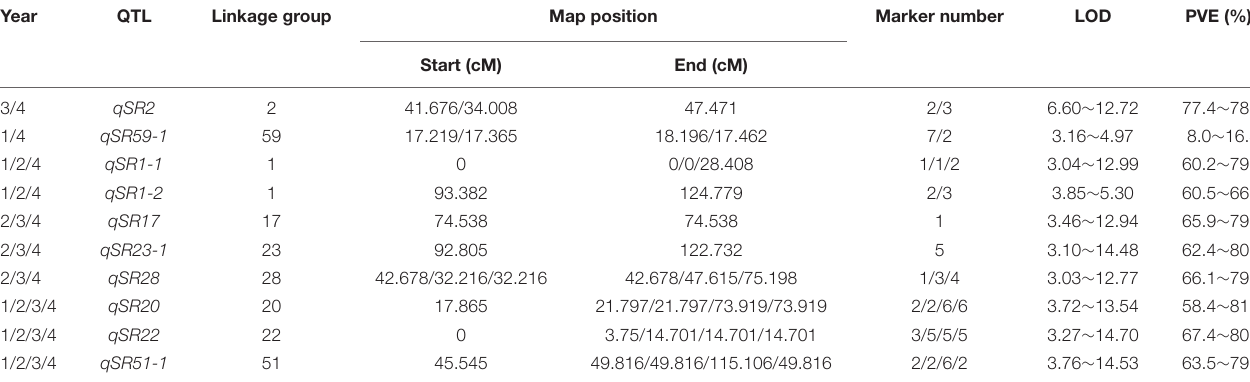
TABLE 4 | Repeatable QTLs associated with the smut resistance of F 1 population derived from GT21 × ROC25 cross.